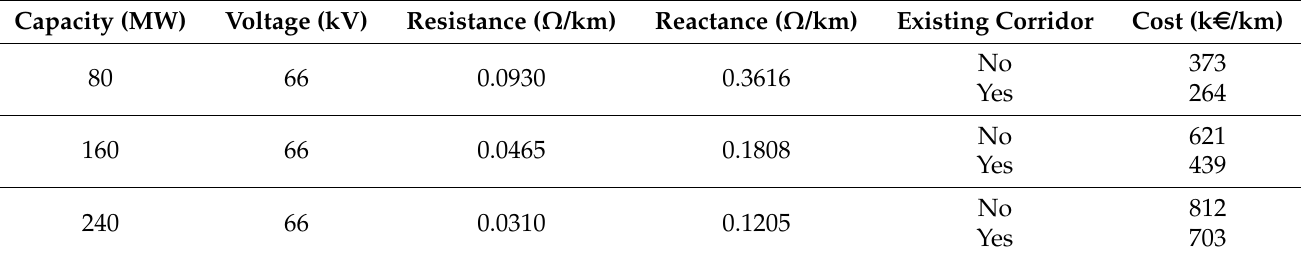
Table 5. Characteristics of candidate lines (LARL-380 (Gull)).